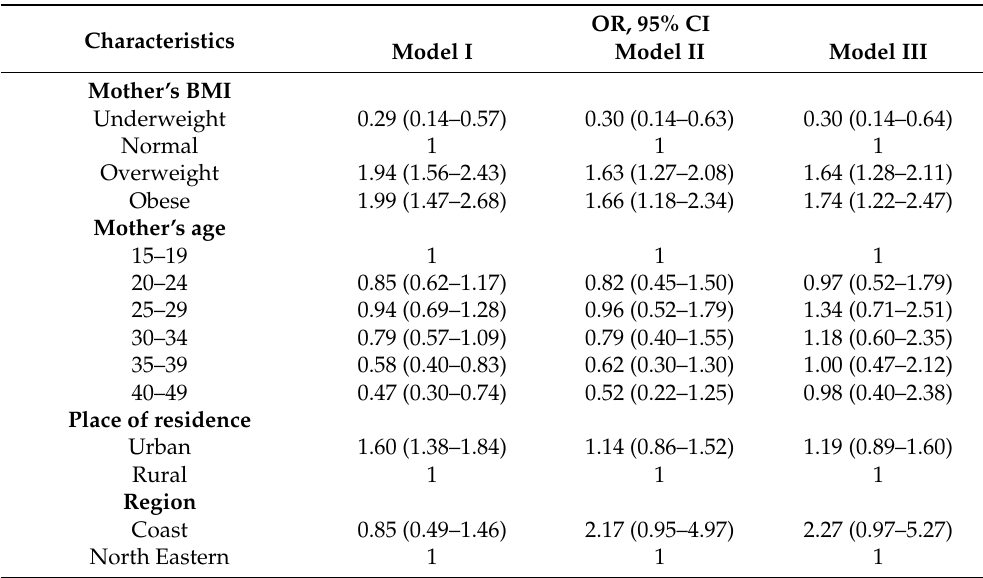
Table 3. Association of maternal and child-related characteristics with child’s Overweight. Odds ratio (OR) and their 95% confidence intervals (CIs) from the logistic regression